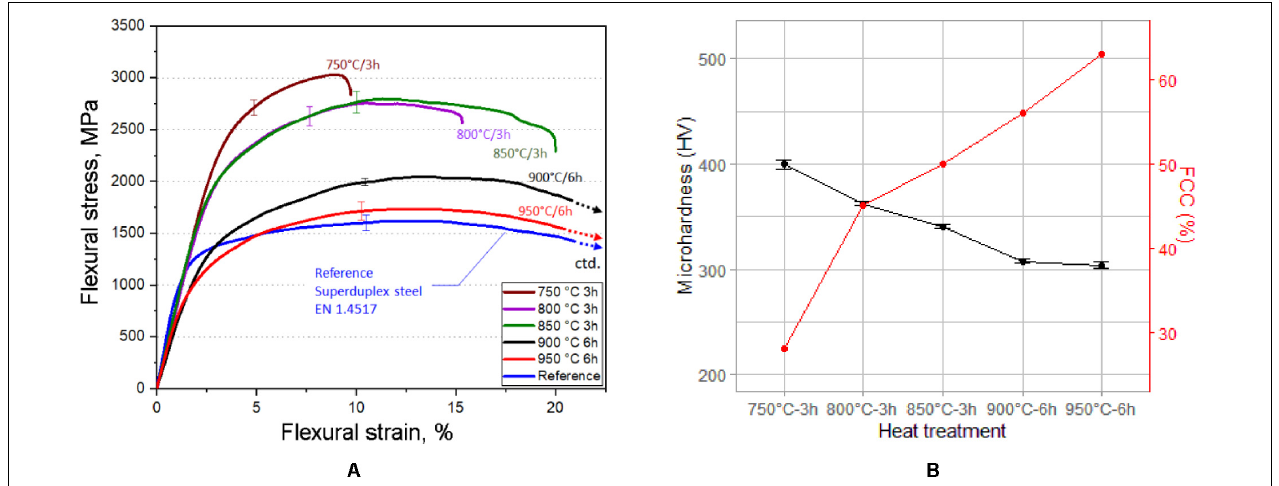
FIGURE 9 | (A) Flexural stress-strain curves, (B) microhardness and FCC percentage of the AlCrFe 2 Ni 2 after heat treatment. TABLE 4 | Mechanical properties based on three-point bending and microhardness tests, including phase percentages in the microstructure measured by EBSD. Coupon BCC% FCC% Proof stress Rp.02 (MPa) Flexural strength (MPa) Flexural strain (%) Hardness (HV1) As-built 95 5 483 ±